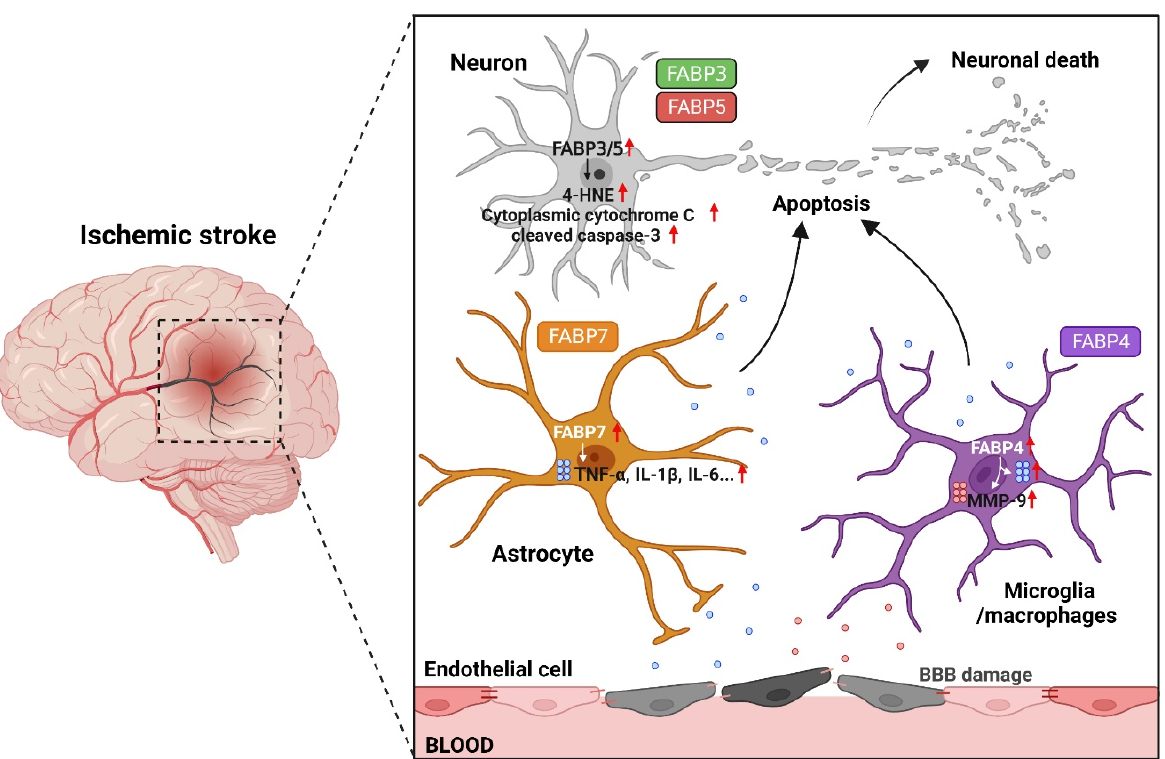
Figure 2. A schematic diagram of the pathway of Faty acid-binding proteins (FABPs) involved in the ischemic injury of neurovascular units. FABP3 and FABP5 are overexpressed in ischemic neurons, mediate oxidative stress, and directly participate in ischemic neuronal death. FABP4 expressed in microglia stimulates the expression and release of pro-inflammatory cytokines (IL-1 β , IL-6, TNF- α ), and matrix metalloproteinase MMP-9 activates extrinsic apoptotic signals in ischemic neurons and disrupts the blood–brain barrier (BBB). FABP7 enhances the pro-inflammatory expression of astrocytes and stimulates ischemic neuronal apoptosis through inflammation. The figure was created with BioRender.com.